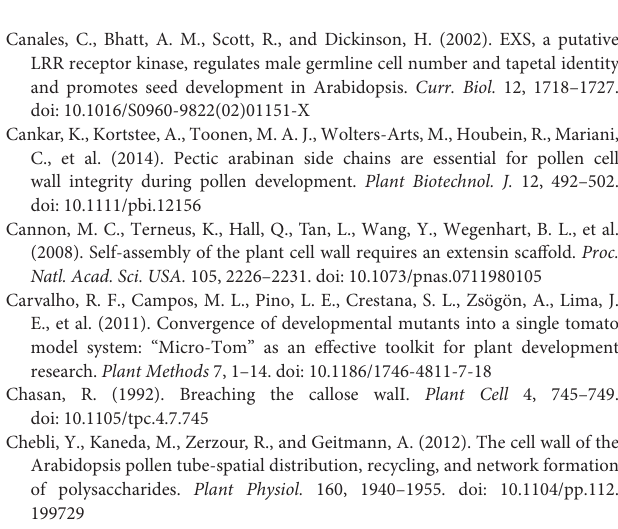
Supplemental Figure 2 | Structure of tomato anther during pollen development. Micrographs of paraffin-embedded anther sections stained with toluidine blue. (A) Sections of 2-mm bud. (B) Sections of 4-mm bud. (C) Sections of 5-mm bud. (D) Sections of 6-mm bud. (E) Sections of 8-mm bud. The arrow marks the Pe, petal; An, anther; Se, sepal; Pi, pistil; MMC, microspore mother cell; Loc, locule; Te, tetrad; Tap, tapetum; MS, microspore; BCP, bicellular pollen; scale bars (A) 75 µ m Supplemental Figure 3 | No primary antibody control for LM antibody staining. Fluorescent micrographs of anther cross sections (500 nm) in LR white, of 8-mm bud anther, stained with Calcofluor white and an FITC-conjugated secondary antibody only. (A) Calcofluor white staining (Left). (B) FITC-conjugated secondary only. Scale bars 25 µ